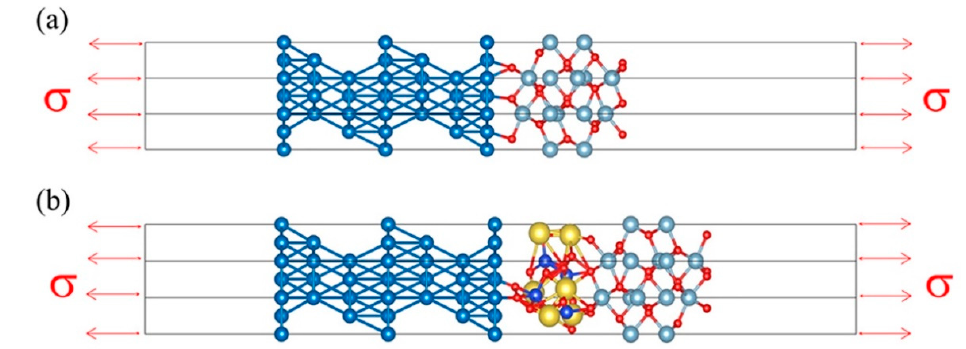
Figure 4. The tensile simulation model for the ( a ) Fe-Al 2 O 3 and ( b ) Fe-amorphous Na 2 SiO 3 -Al 2 O 3 interfaces.